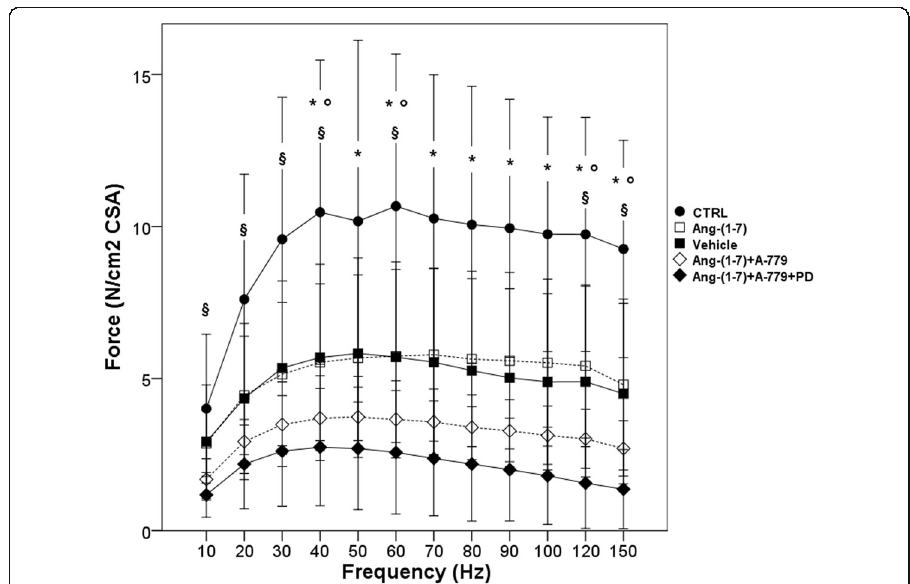
Fig. 1 Diaphragm force-frequency relationship. CTRL ( n = 8): unventilated controls; vehicle ( n = 10): VIDD + saline treatment; Ang-(1 – 7) (n = 10): VIDD + Ang-(1 – 7) treatment; Ang-(1 – 7) + A-779 ( n = 10): VIDD + Ang- (1 – 7) + A-779 treatment; Ang-(1 – 7) + A-779 + PD ( n = 7): VIDD + Ang-(1 – 7) + A-779 + PD123319